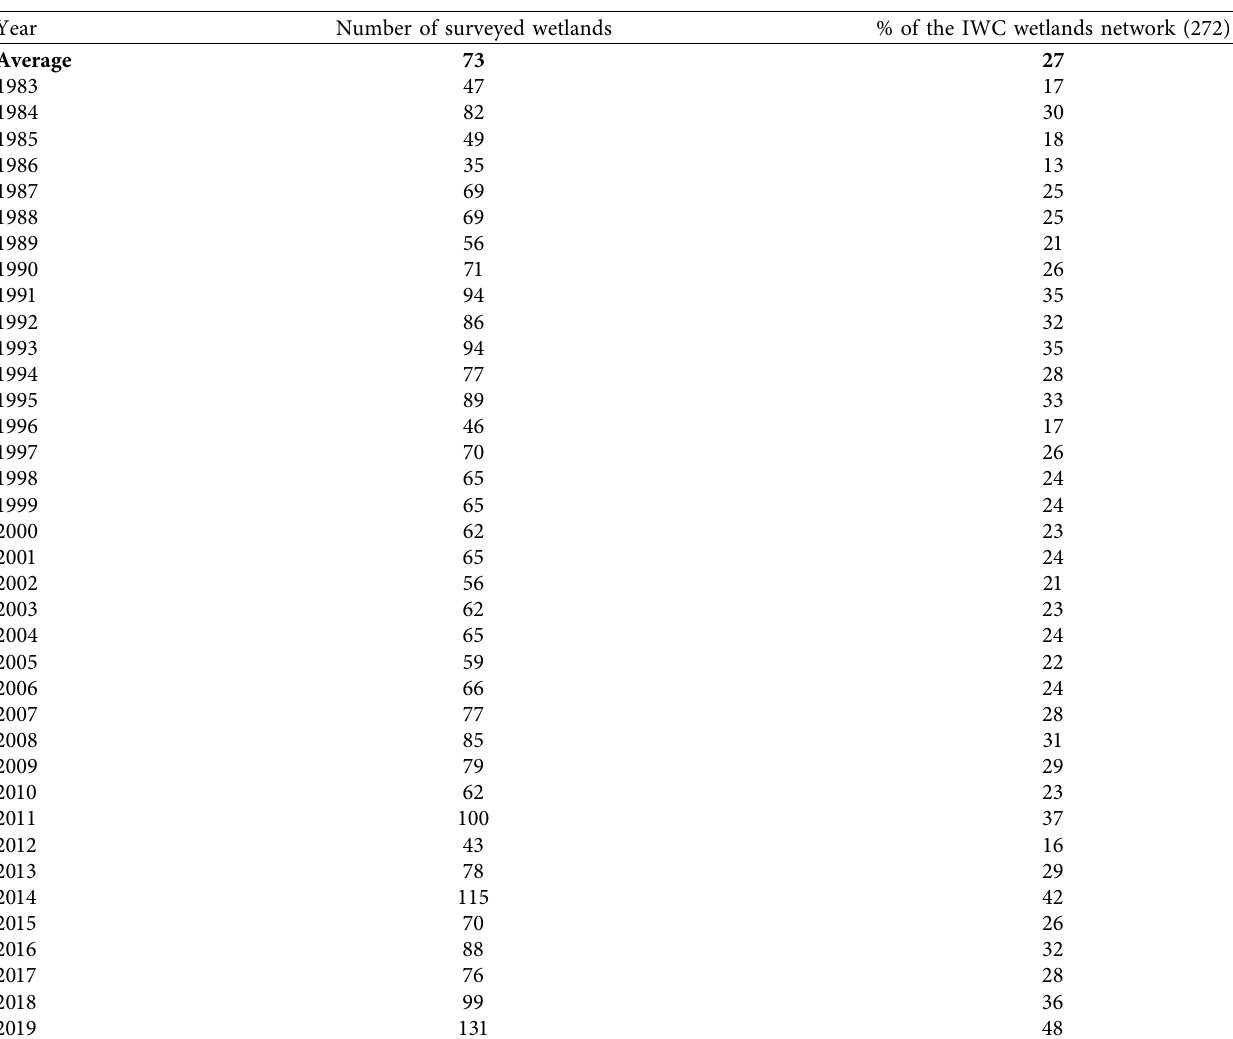
Table 1: Number and percentage of wetlands visited per